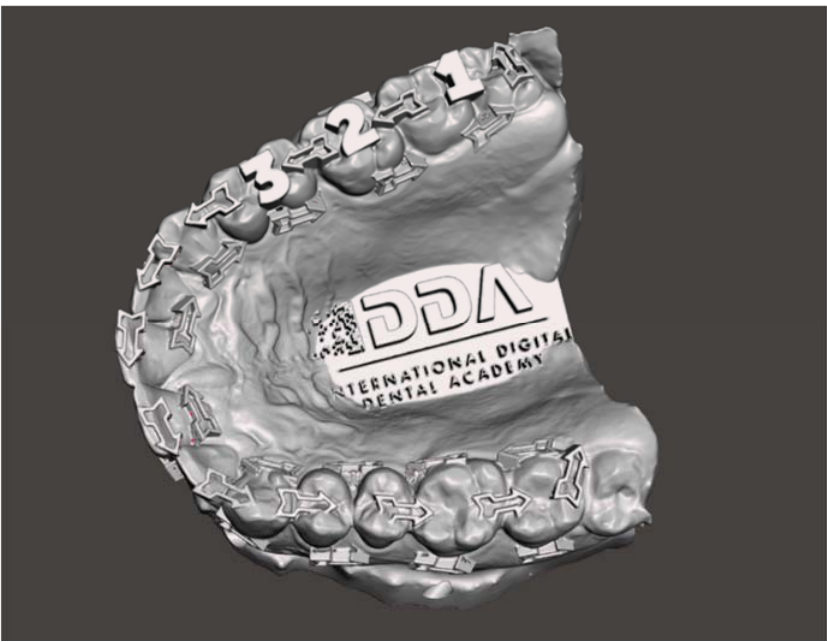
Figure 2. The IDDA Scan Method Training Model.